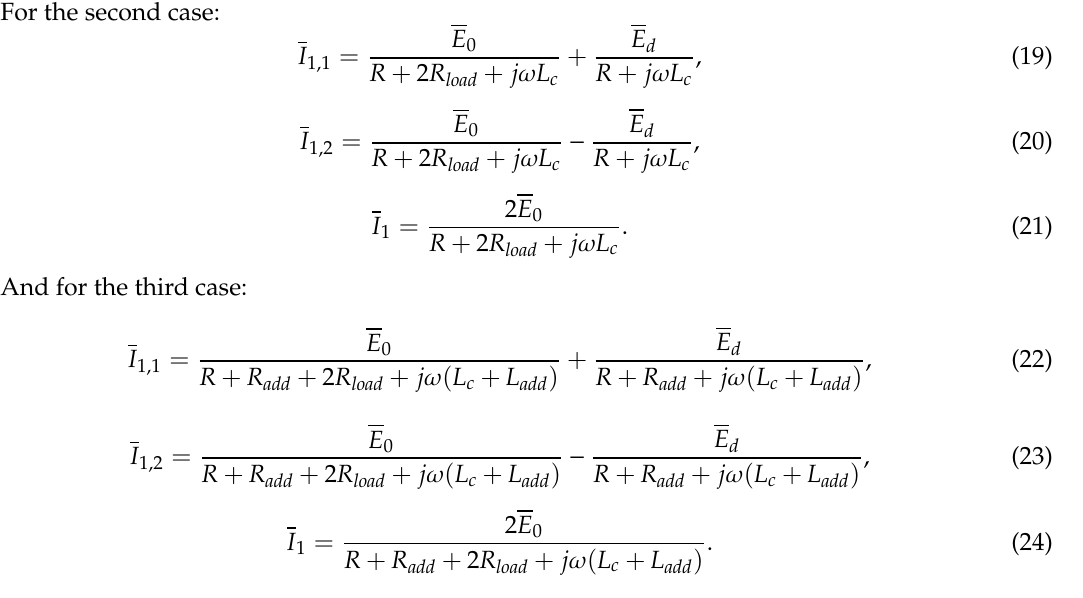
Figure 17. Bearing forces as a function of the rotor displacement (x-axis) for a spin speed of 6000 rpm. Measures when the generator is left in open circuit, and when connected to a 200 Ω charge, and comparison with the model predictions; ( a ) restoring force and ( b ) destabilizing force.